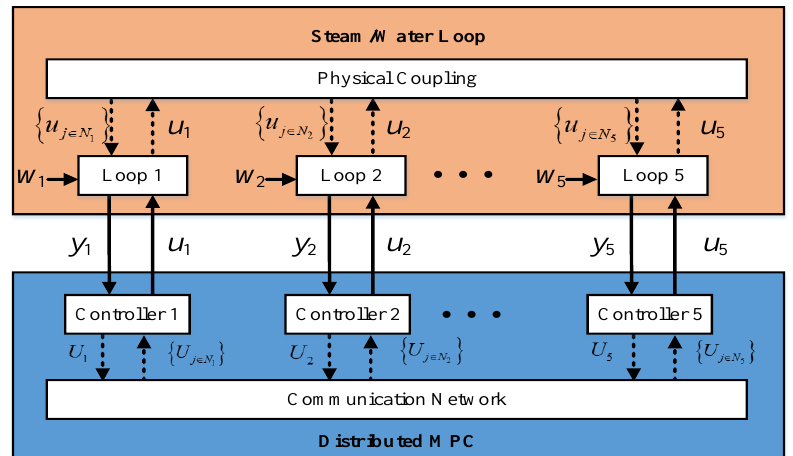
Figure 5 A conceptual representation of the distributed MPC architecture [33] (Reproduced with permission from Maxim, A.; Copot, D.; De Keyser, R.; and Ionescu, C.M., Journal of Process Control; published by Elsevier, 2018).